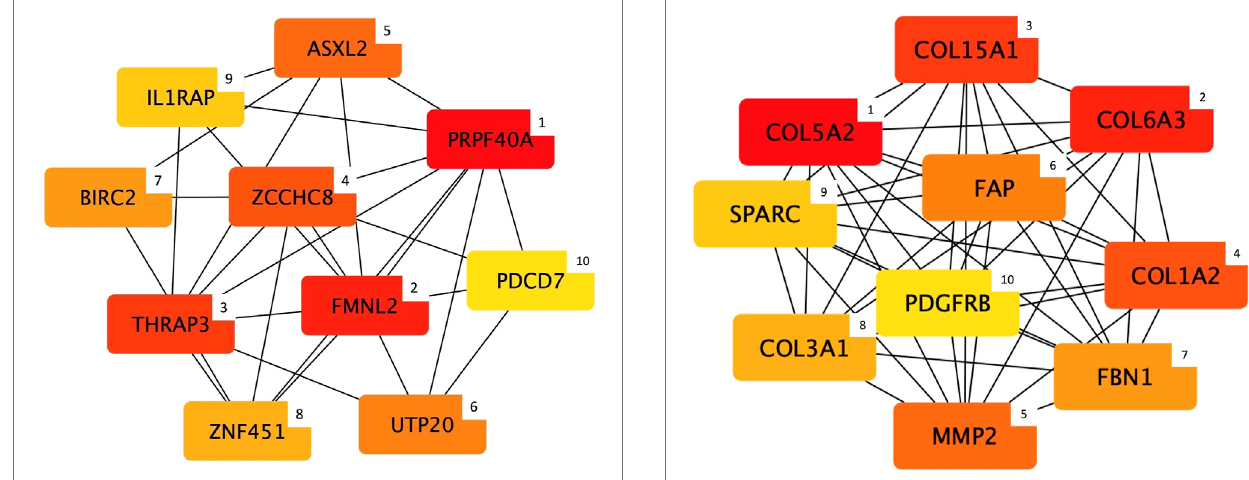
FIGURE 5 | Top 10 hub genes entering the protein content module (i.e., group of co-expressed genes and whose mRNA level covaried with the crude protein content in normal and White Striping/Wooden Breast affected Pectoralis major muscles in 52-day-old broilers. Connections show how functional categories interact with each other). The cytoHubba output shows hub nodes with the most signi fi cant MCC values (i.e., genes characterized by the highest number of connections in the considered network). Besides, the plugin classi fi es the 10 hub genes by ranking them considering their MCC value and using a color-ranging scale: from the dark red (most important hub gene) to the light-yellow (less important hub gene), also indicated by a numerical scale from 1 (most important) to 10 (less